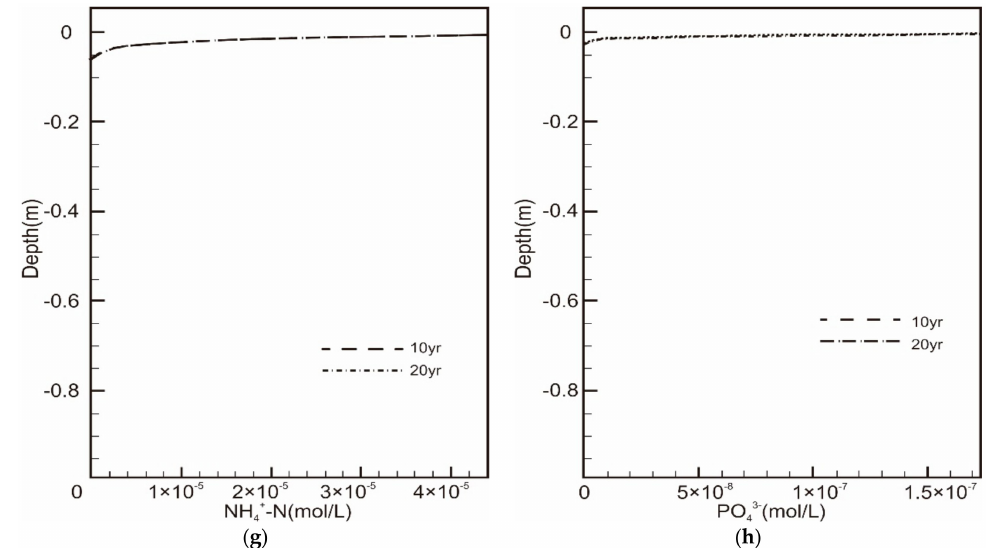
Figure 1. Results of chemical pollutant transport in the column. ( a ), ( b ), ( c ), ( d ), ( e ), ( f ), ( g ) and ( h ) were the pollutants’ infiltration curve for Fe 3 + , Zn 2 + , Mn 2 + , Pb 2 + , Cu 2 + , Cd 2 + , NH 4 + -N and PO 43 − , respectively.